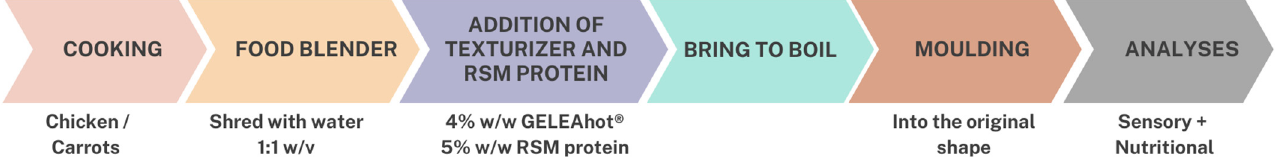
Figure 2. Flow-chart of TM chicken breast and TM carrot preparation.